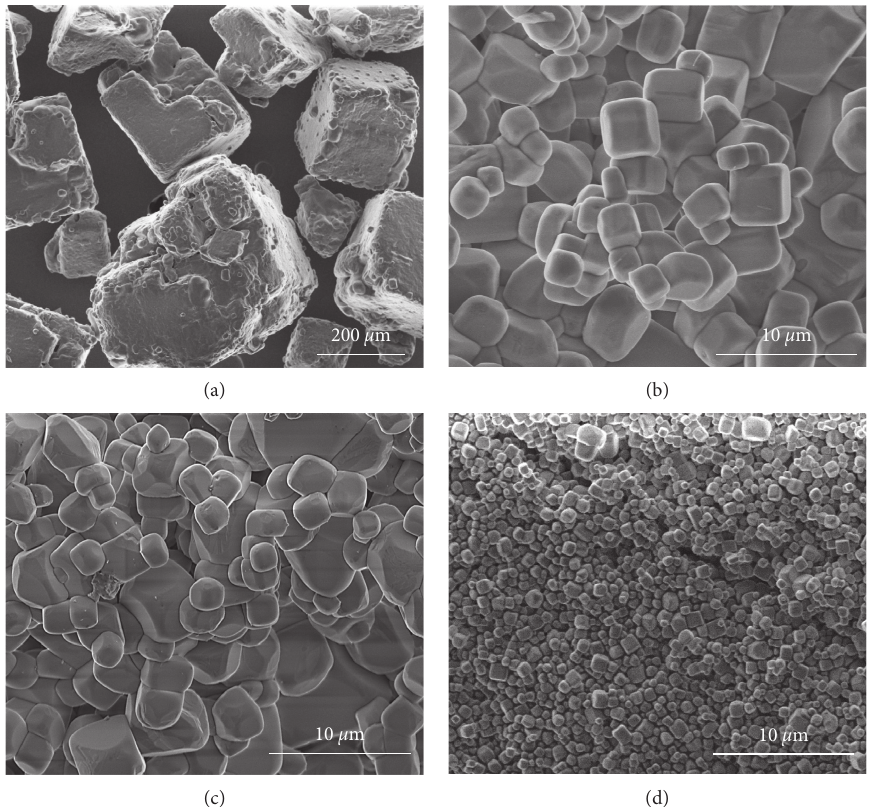
Figure 2: SEM micrographs showing different obtained sizes of NaCl. Sequence 1: (a) commercial NaCl; (b) NaCl after using 2-propanol; and (c) NaCl obtained by centrifugation. Sequence 2: (a) and (b) followed by (d) NaCl obtained after